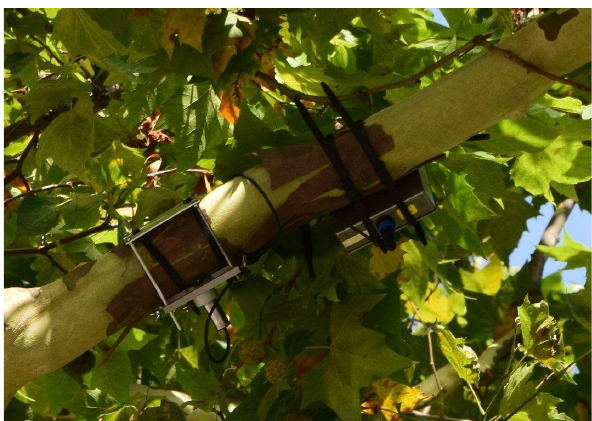
Figure 6. "PepiPiaf sensor: measurement of diameter variation of a branch.